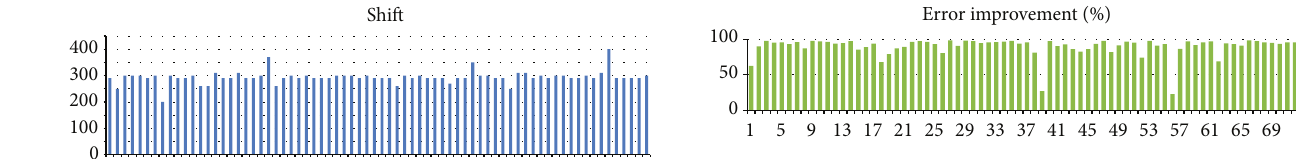
Figure 8: Improved percentages of error after adjustment.